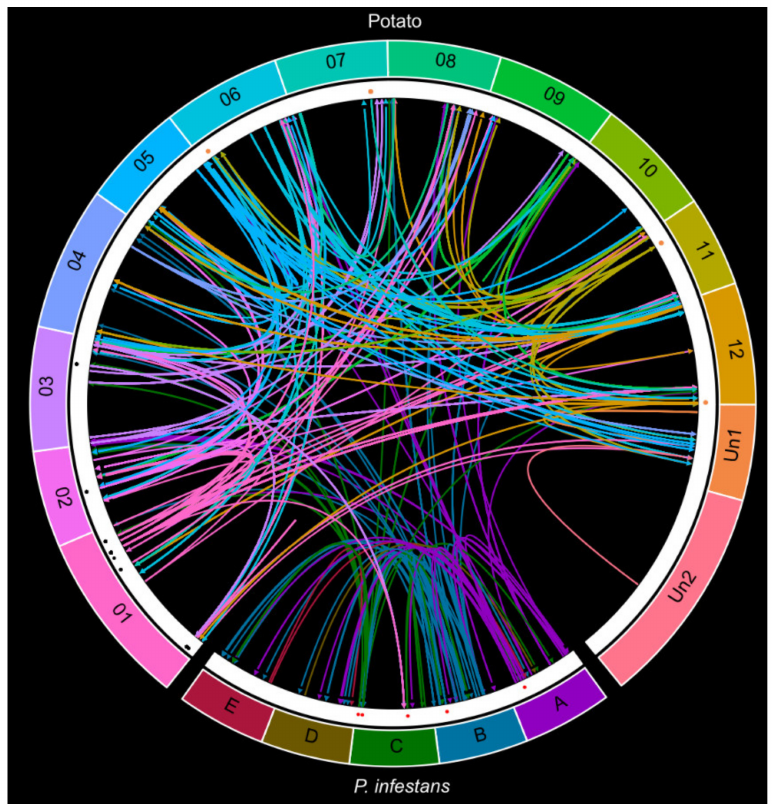
Figure 5. Precursor and target sites of endo- and exogenous sRNAs in NFA-increased datasets. Organized chromosome vice (potato) or as groups of supercontigs (A–E) for P. infestans . Un1 and Un2 are the unanchored sequences from potato genome version 4.03 and 4.04, respectively. The arrows represent the connection between each source and target (arrowhead) and are colored according to the precursor chromosome or region. Colored dots in the white margin represent the following category of source sRNA loci: phasiRNAs (orange), TE (red), miRNAs